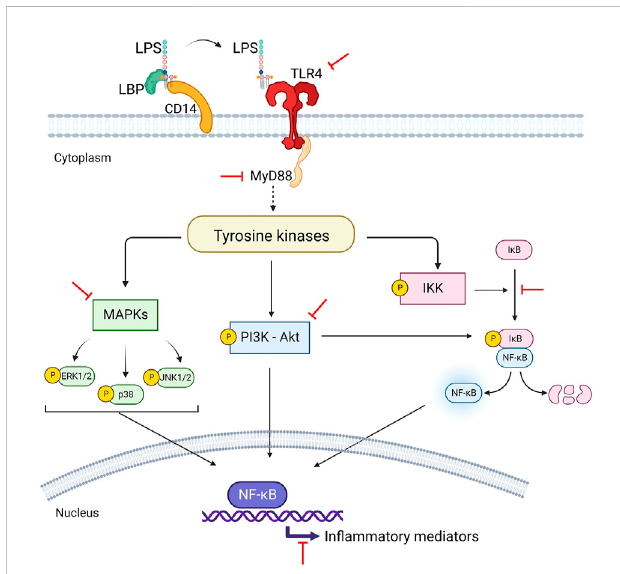
FIGURE 4 Hypophyllanthin-mediated inhibition of lipopolysaccharide (LPS)- dependant NF- κ B, MAPK and P13K-Akt signaling pathways in human